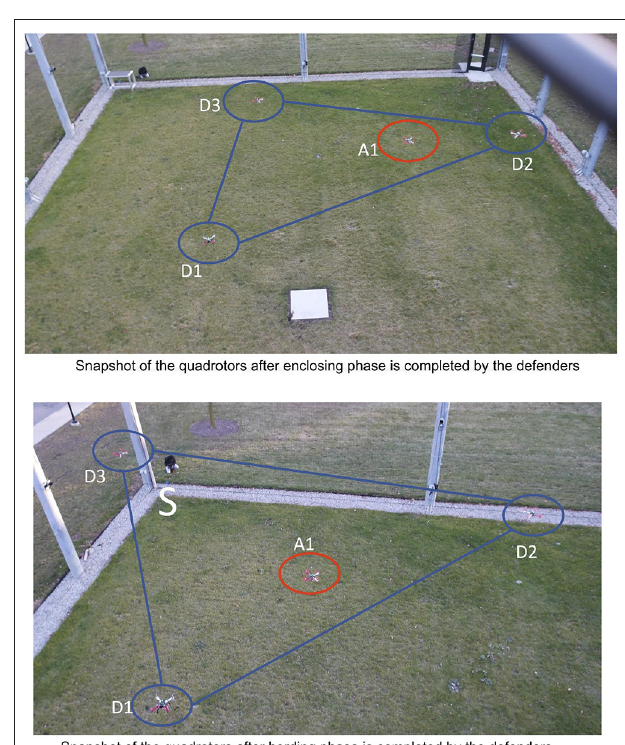
are completed by the